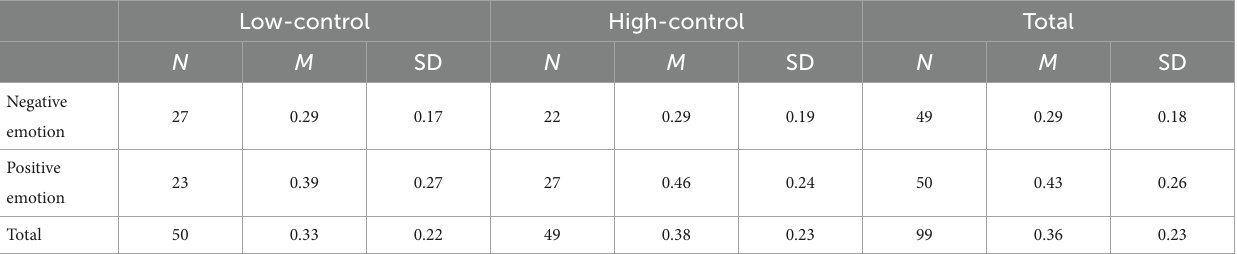
TABLE 3 Descriptive statistics of cognitive reflection test (CRT) accuracy between the metacognitive control ability groups and emotion manipulation in Experiment 2. Low-control High-control